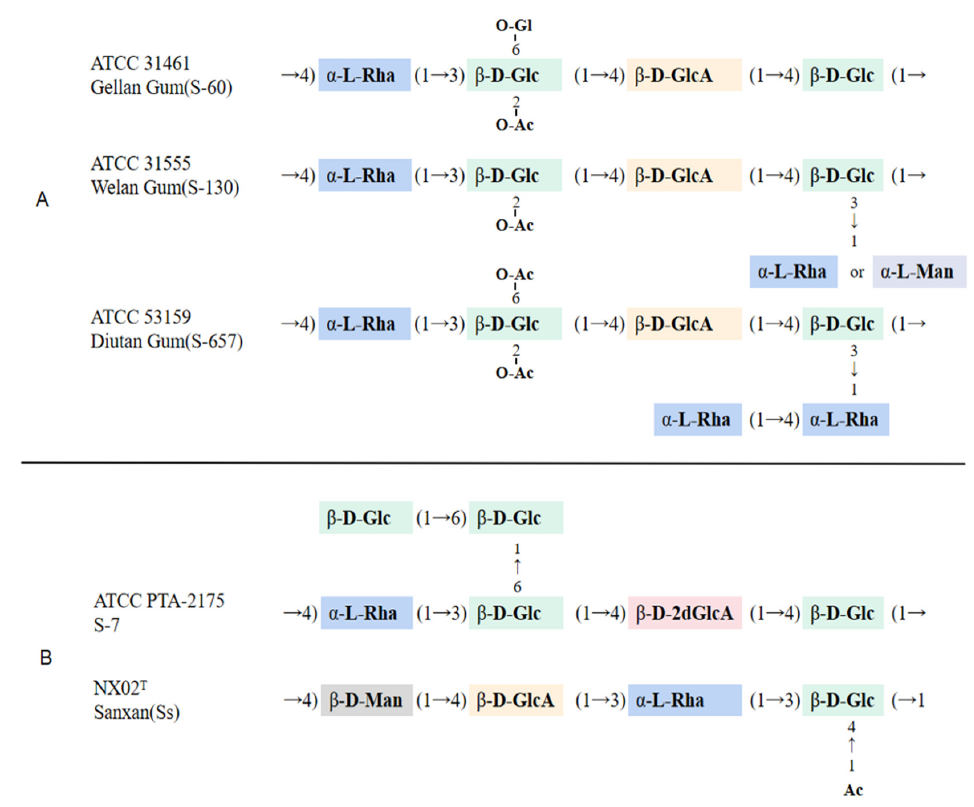
Figure 2. ( A ) Structures of traditional sphingans. ( B ) Structures of new reported